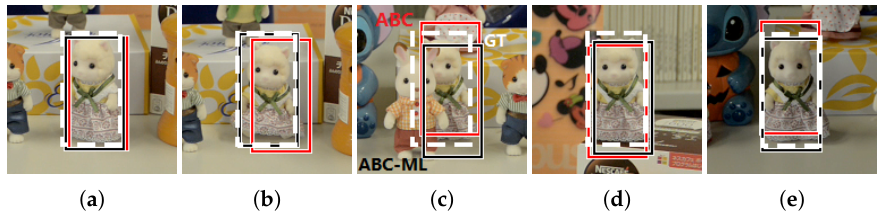
Figure 12. Comparison of matching precision between ABC and ABC-ML. ABC and ABC-ML results show in red and black bounding boxes. Ground truth is shown by white bounding box. ( a ) Rotation, ( b ) Deformation, ( c ) Occlusion, ( d ) Scale variation, ( e ) Illumination.